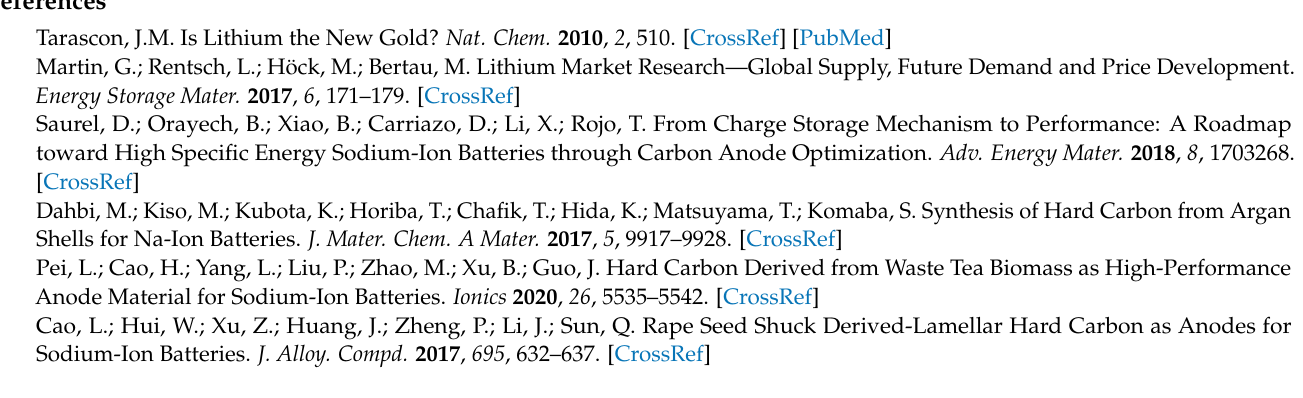
carbons; Table S2: Results of the EDX analysis of HC samples; Figure S3: SEM images of